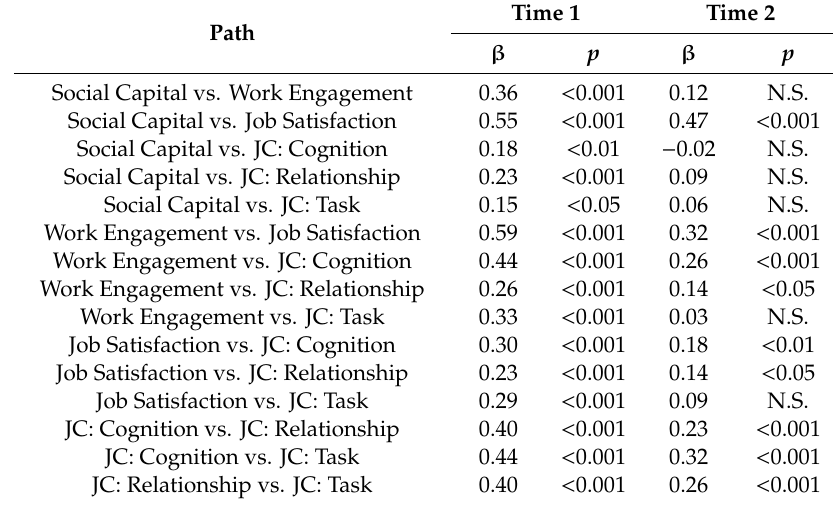
Figure 1. Main-effect model (where W. means work, and JC means job crafting). Dashed line indicates that the relationship was not significant at p < 0.05. Table 2. Standardized estimates and p -values for concurrent variance in the main-effect model.